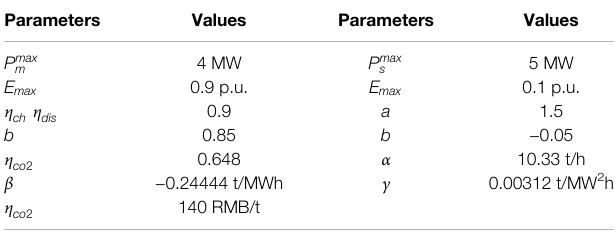
TABLE 1 | Operation parameters.